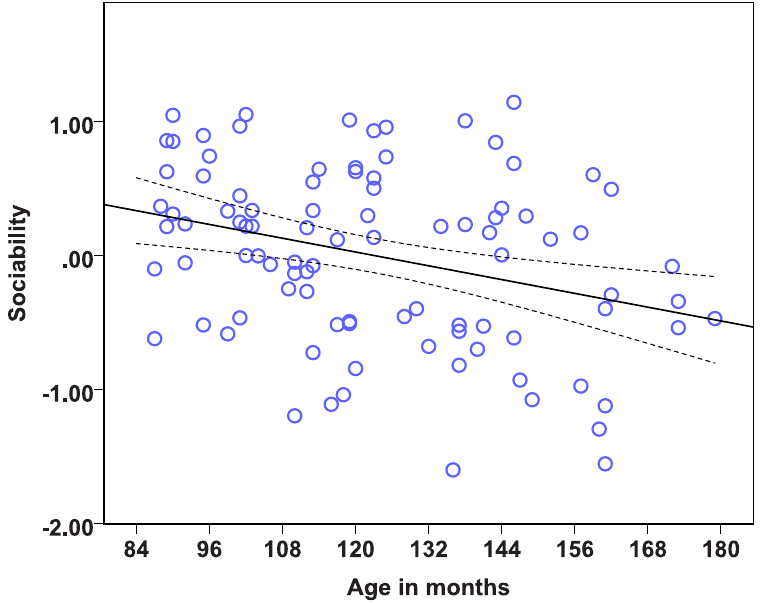
Fig 2. Scatter plots showing the relationship between age in months and sociability [with 95% confidence intervals (dotted lines)]. A significant effect of age in months was present on the factor Sociability ( η 2 = 0.10, p =